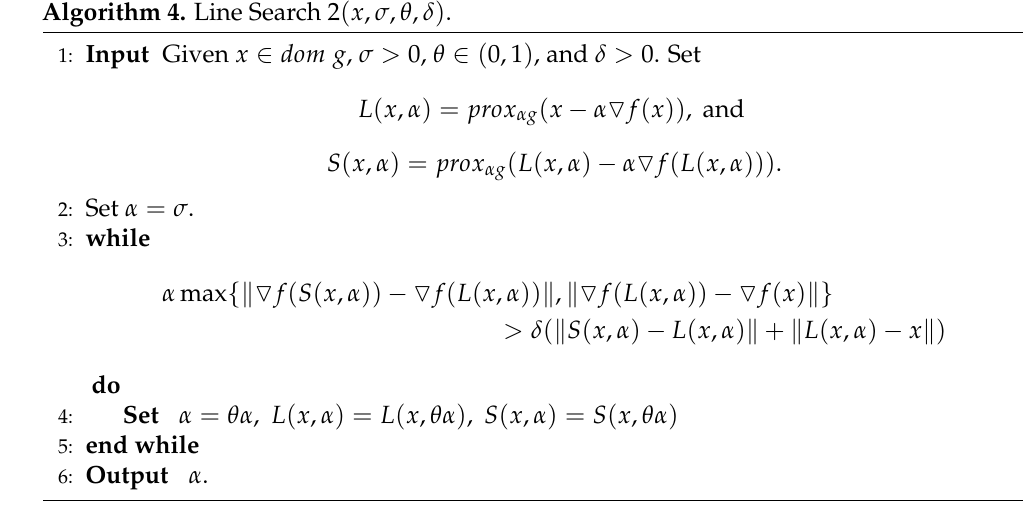
Algorithm 4. Line Search 2 ( x , σ , θ , δ ) .